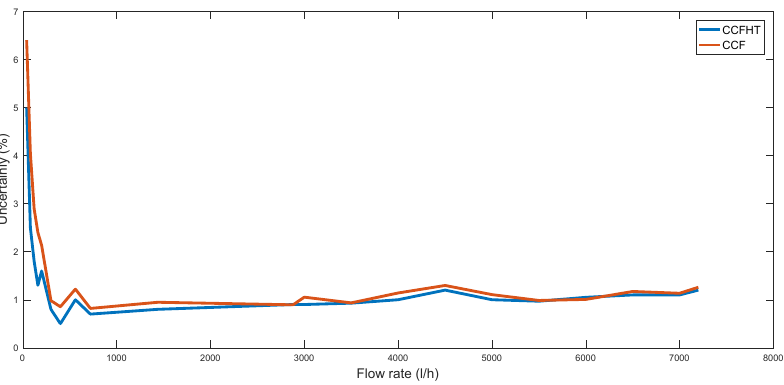
Figure 26. Uncertainty achieved for CCF and CCFHT cases.